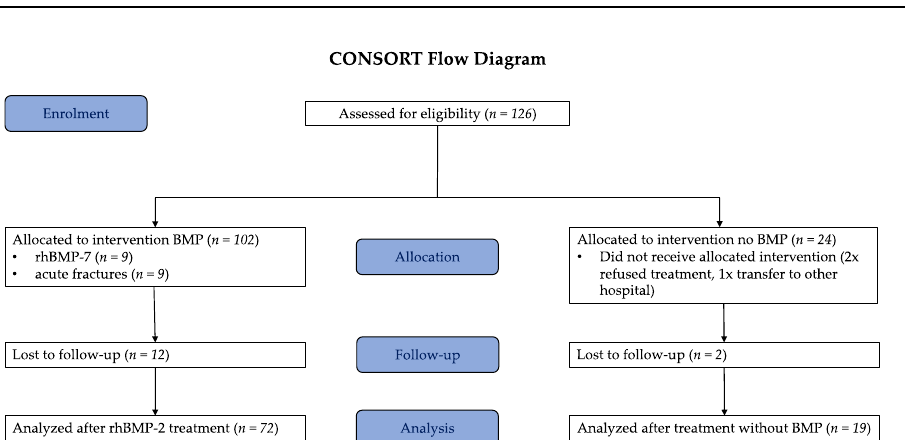
Figure 1. Consort flow diagram indicating enrolment, intervention allocation, and follow